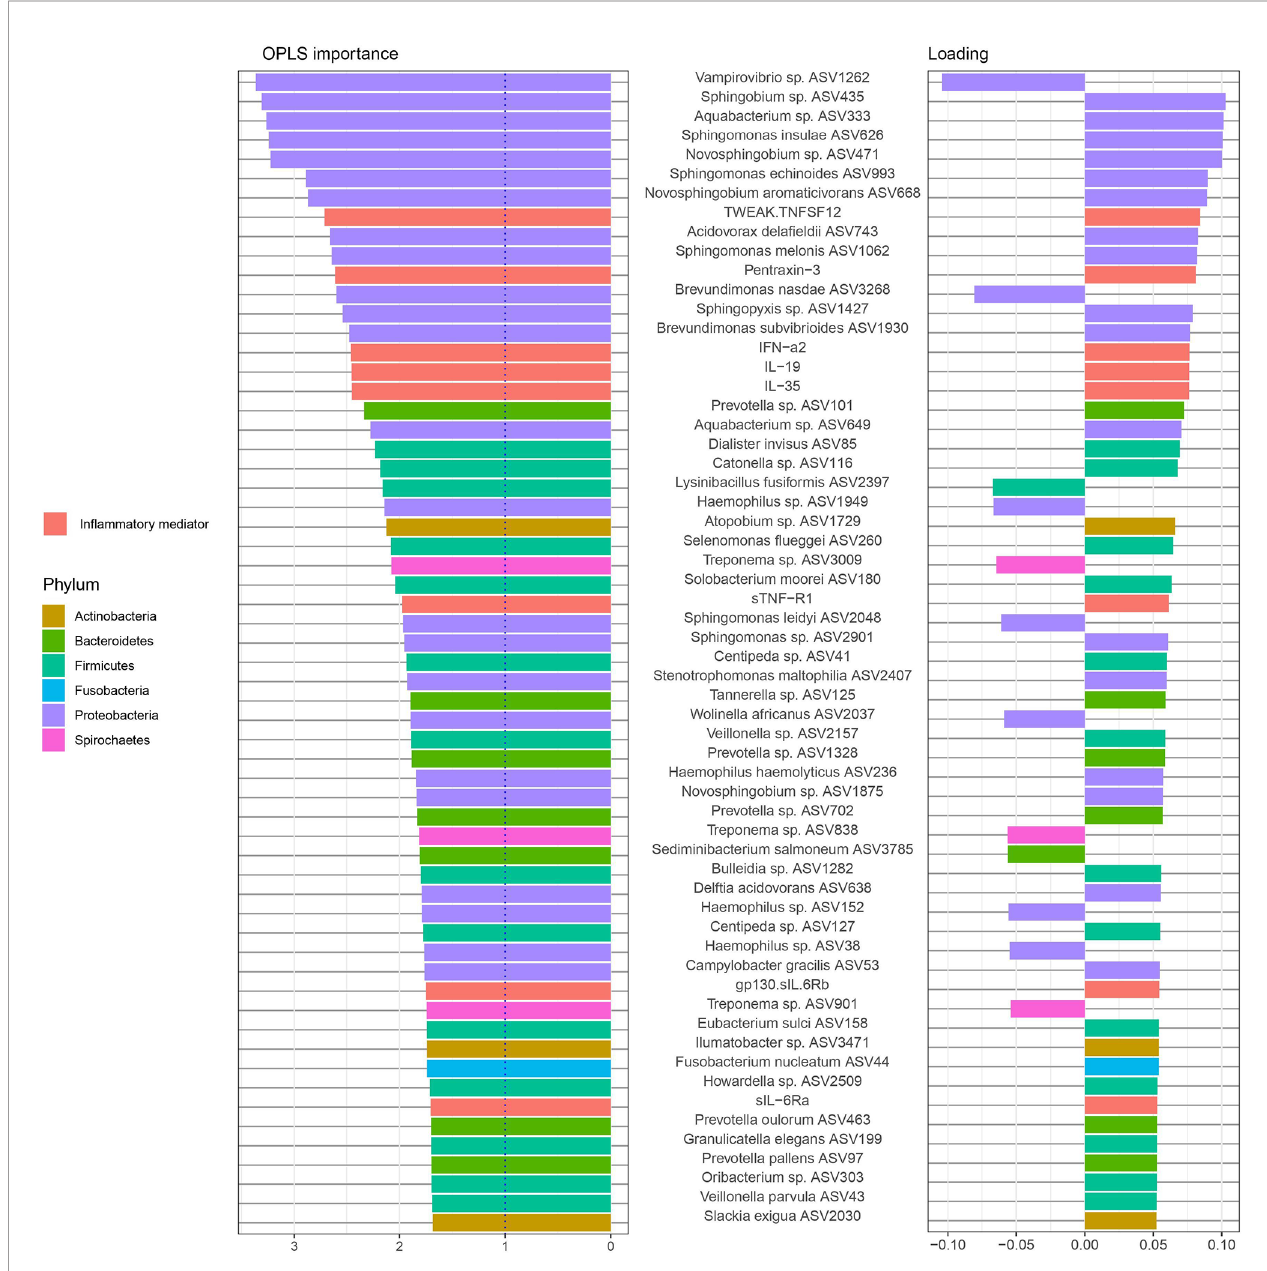
FIGURE 6 | Amplicon sequences variants (ASVs) and in fl ammatory mediators/cytokines in saliva samples identi fi ed by Orthogonal Partial Least Squares Discriminant Analysis (OPLS-DA) analysis. In OPLS-DA, a single component serves as a predictor for the class. The sixty most important variables (with VIP > 1) for the classi fi cation of saliva samples from patients with and without RA are shown. The variable loading on the predictive component is shown (positive = discriminatory direction RA, negative= discriminatory direction non-RA). The lowest annotated taxonomic rank is shown for each ASV as well as the ASV IDs used for the